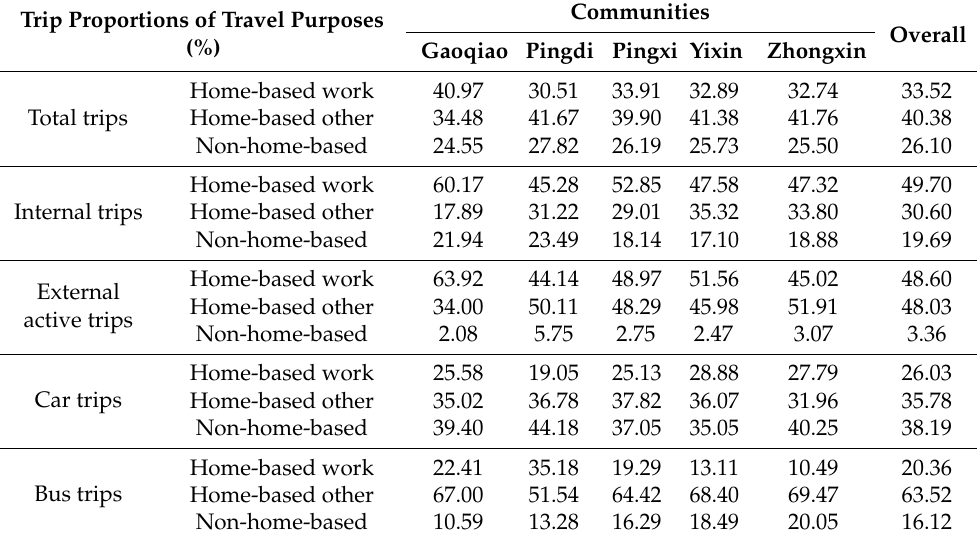
Table 4. Estimated distribution patterns of travel purposes of the ILCC Core Area in 2016. Trip Proportions of Travel